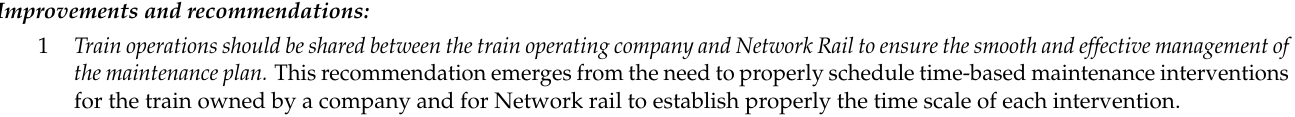
Box 13. Detail description of new recommendation for Network Rail management